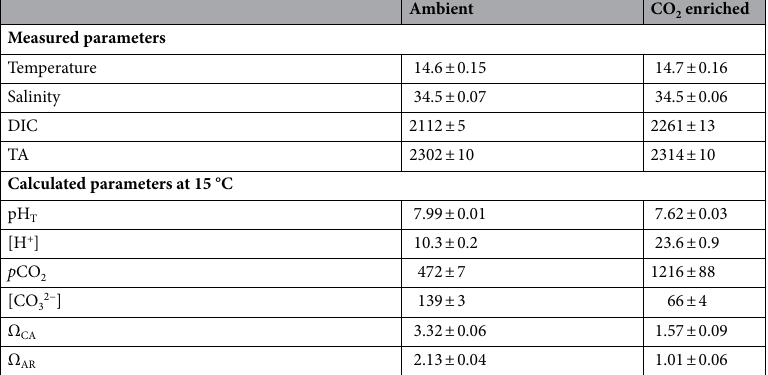
Table 1. Properties of ambient and CO 2 enriched seawater (mean ± 1 SD) in the experimental units. Temperature (°C) and salinity are averages of 22 daily measurements whereas DIC and TA (µmol kg SW −1 ) are averages of five measurements taken during the final 10 d of the experiment when the pH was stabilised at the target value (Fig. S1). Seawater pH (total scale), [H + ] (nmol L −1 ), p CO 2 (μatm), [CO 32− ] (µmol kg SW −1 ). The calcite and aragonite saturation states (Ω CA and Ω AR , respectively) were derived from the measured parameters for a temperature of 15